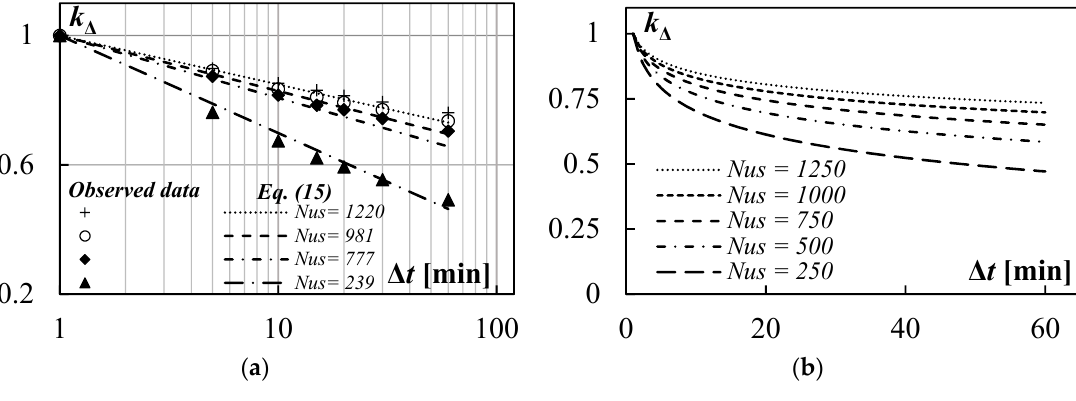
Figure 7. ( a ) Comparison of the observed data and Equations (15) and (16); and ( b ) abacus of the corrective coefficient k ∆ for different values of N us